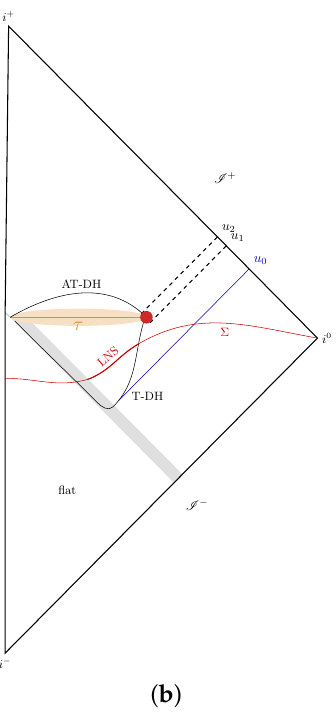
Figure 2. ( a ) Part of space–time in which the semi-classical approximation holds. The shaded region depicts an infalling massless scalar field that would give rise to a singularity in classical GR. But loop quantum gravity (LQG) quantum geometry effects intervene to prevent the formation of this singularity. This quantum geometry region and its future are excised (dashed line with scissors). A trapping dynamical horizon (TDH) develops which is space-like with increasing area (in the outward direction) during the collapse, and time-like with decreasing area (in the future direction) during + . Hawking radiation evaporation. Null rays from the contracting part of the TDH go out to meet I starts in earnest at u = u 0 . The dashed line with scissors that includes the last ray u = u LR represents the future boundary of the semi-classical region. Evolution from the initial Cauchy surface Σ i to generic Cauchy surfaces Σ that lie entirely in the semi-classical region is unitary. However, evolution from Σ to the portion of Σ f that lies within the semi-classical region is not. ( b ) Proposed quantum extension of the space–time. The classical singularity is replaced by a transition surface τ , to the past of which we have a trapped region, bounded in the past by a trapping dynamical horizon T-DH, and to the future of which we have an anti-trapped region bounded by an anti-trapping dynamical horizon (AT-DH). Cauchy surfaces Σ develop astronomically long necks already in the semi-classical region and the long necks persist also in the quantum region. Partner modes that fall in the trapped region get stretched enormously and are slowly released to the future of the quantum region. Thus, ‘most of the purification’ occurs to the future of the transition surface τ . The dark (red) blob at the right end of τ is a genuinely quantum region discussed in Sections 2.3 and